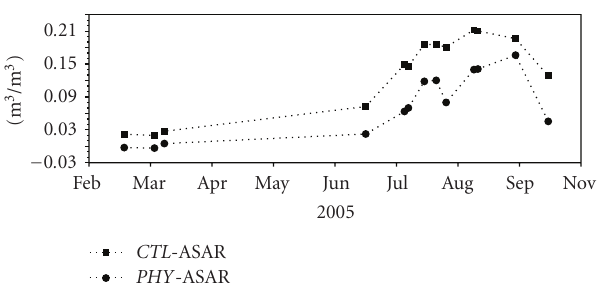
Figure 5: Comparison between surface soil moisture simulated and estimated from ASAR radar data. The domain average bias between the simulations and each ASAR image over Dantiandou Kori are